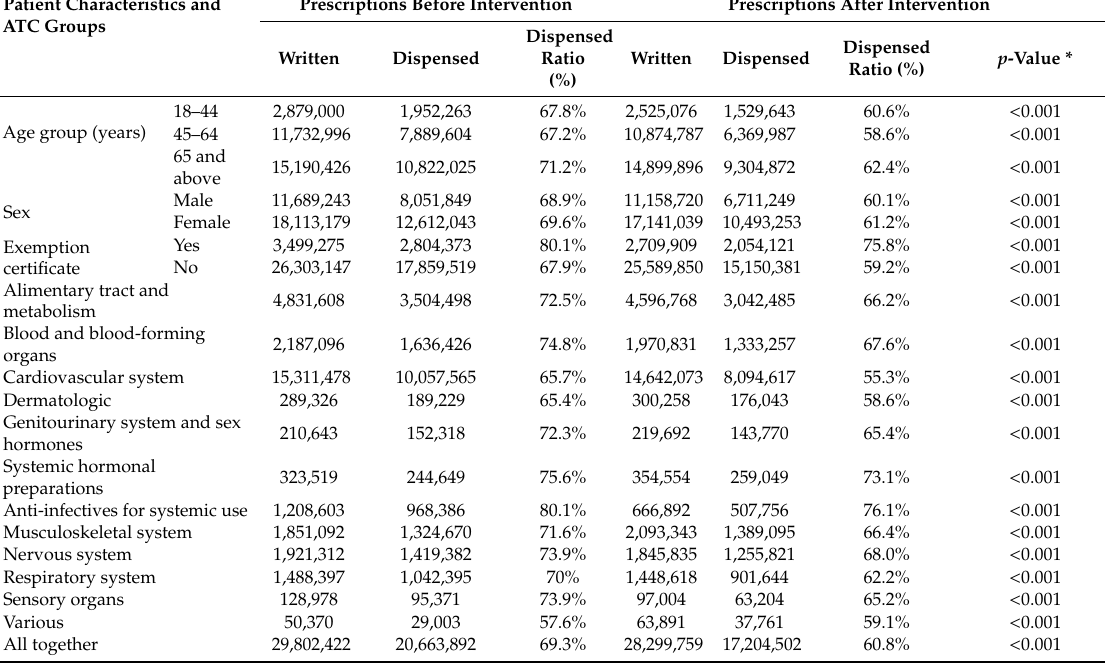
Table 2. The proportion of dispensed medications prescribed by general practitioners (GPs) in Hungary in the first quarter of 2012 (before-intervention) and in the third quarter of 2015 (after the program implementation) by patient sociodemographic characteristic and anatomical–therapeutic chemical classification (ATC) drug